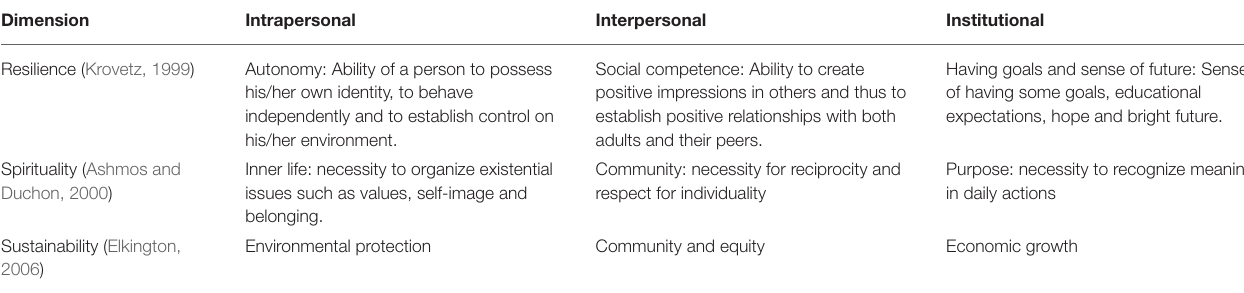
TABLE 1 | Relationship between resilience, organizational spirituality and sustainability.